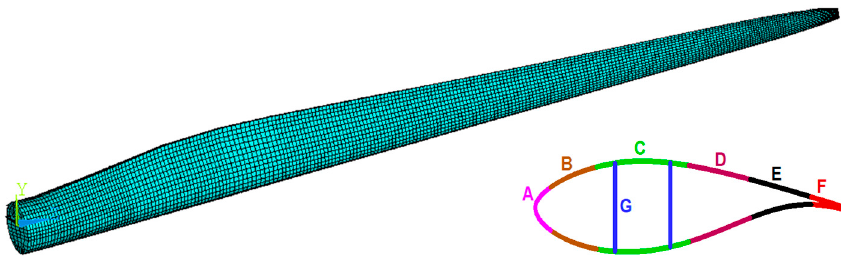
Figure 28. Finite element mesh and panel models of cross section (A: leading edge (LE), B: sandwich panel of leading edge (LE-SP), C: spar cap, D: sandwich panel of trailing edge (TE-SP), E: reinforcement panel of trailing edge (TE-RP), F: trailing edge (TE), G: shear webs).